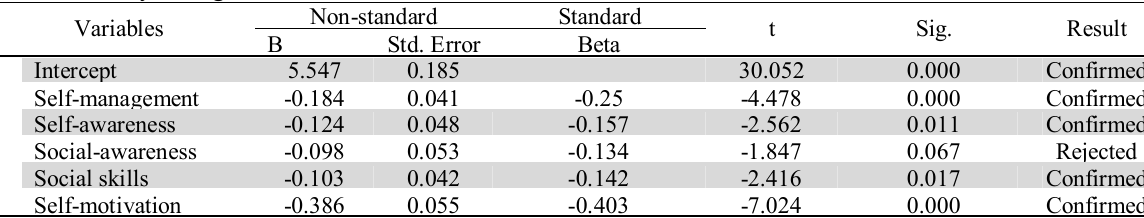
The summary of regression model Variables